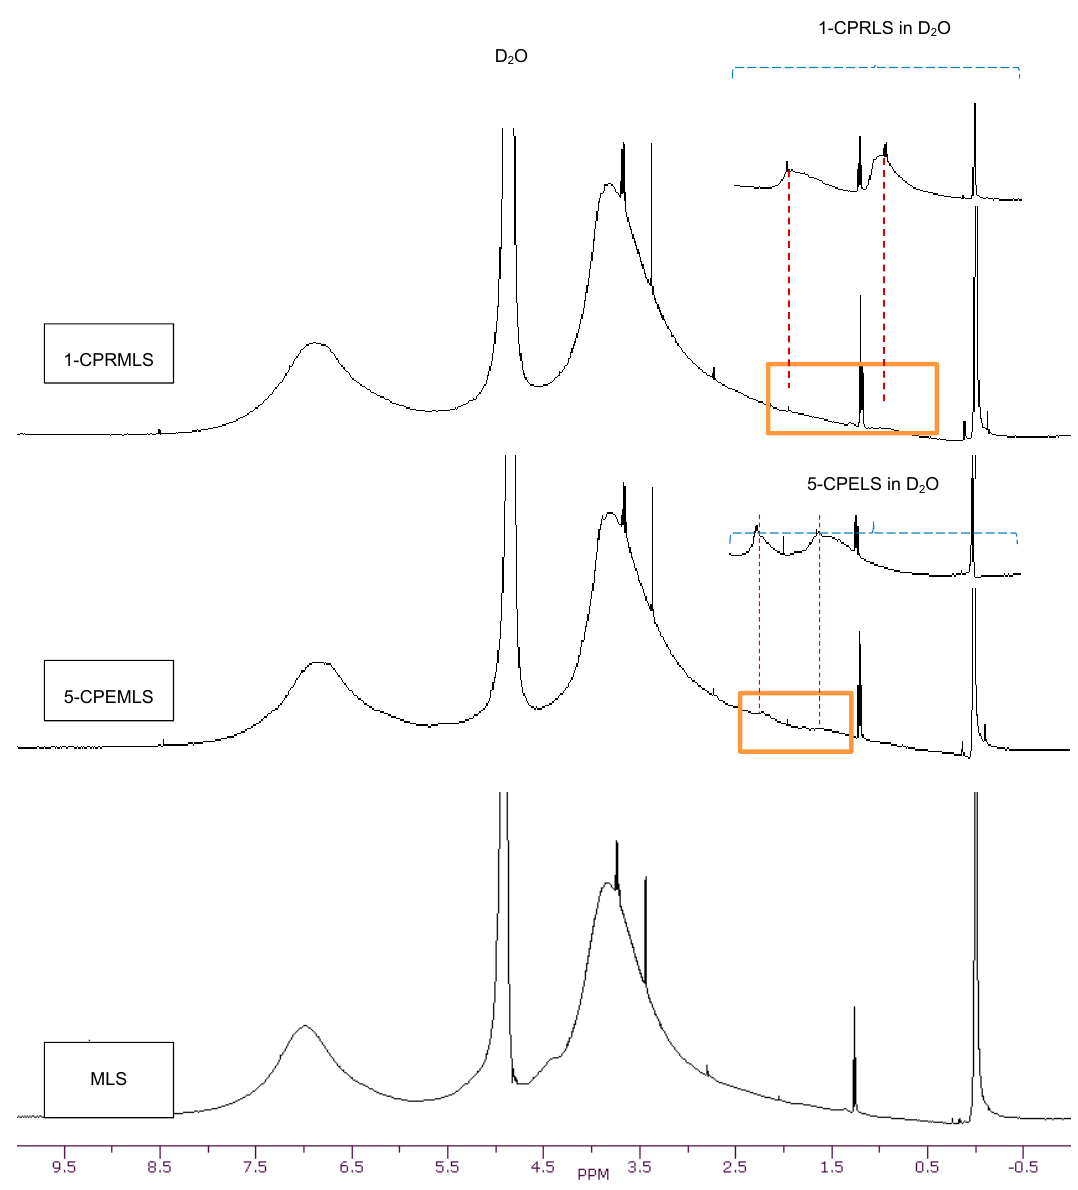
◦ 2 O solutions at 25